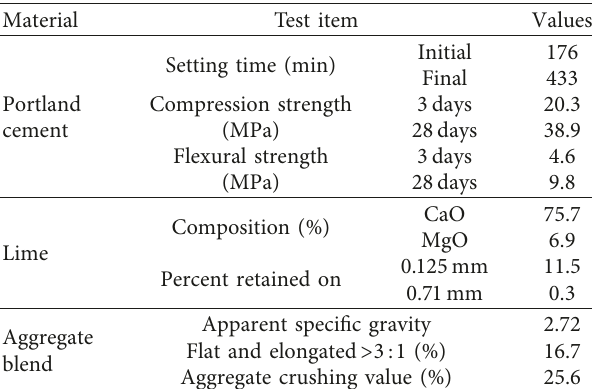
Table 3: Properties of Portland cement, lime, and aggregate blend.